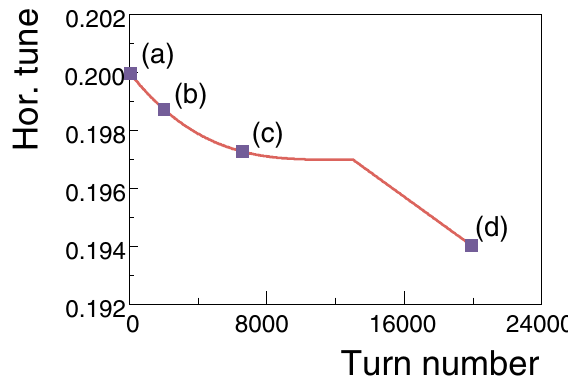
FIG. 9. (Color) Evolution of the tune used for the simulation of a six-turn extraction ( p (cid:1) 3 ). The four points labeled with letters correspond to the tune values at which the beam dis- tribution is shown in Fig.